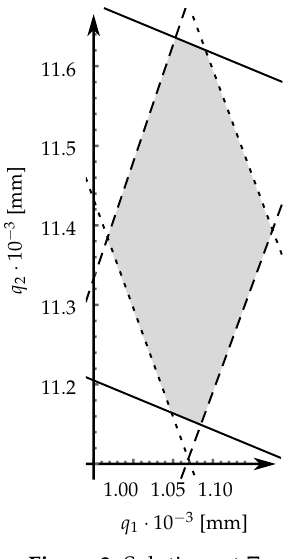
Figure 3. Solution set Ξ uni .